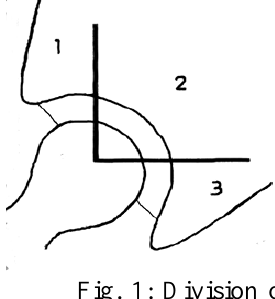
Fig. 1: Division of the acetabular component into zones according to J.G. DeLee and J. Charnley (13)